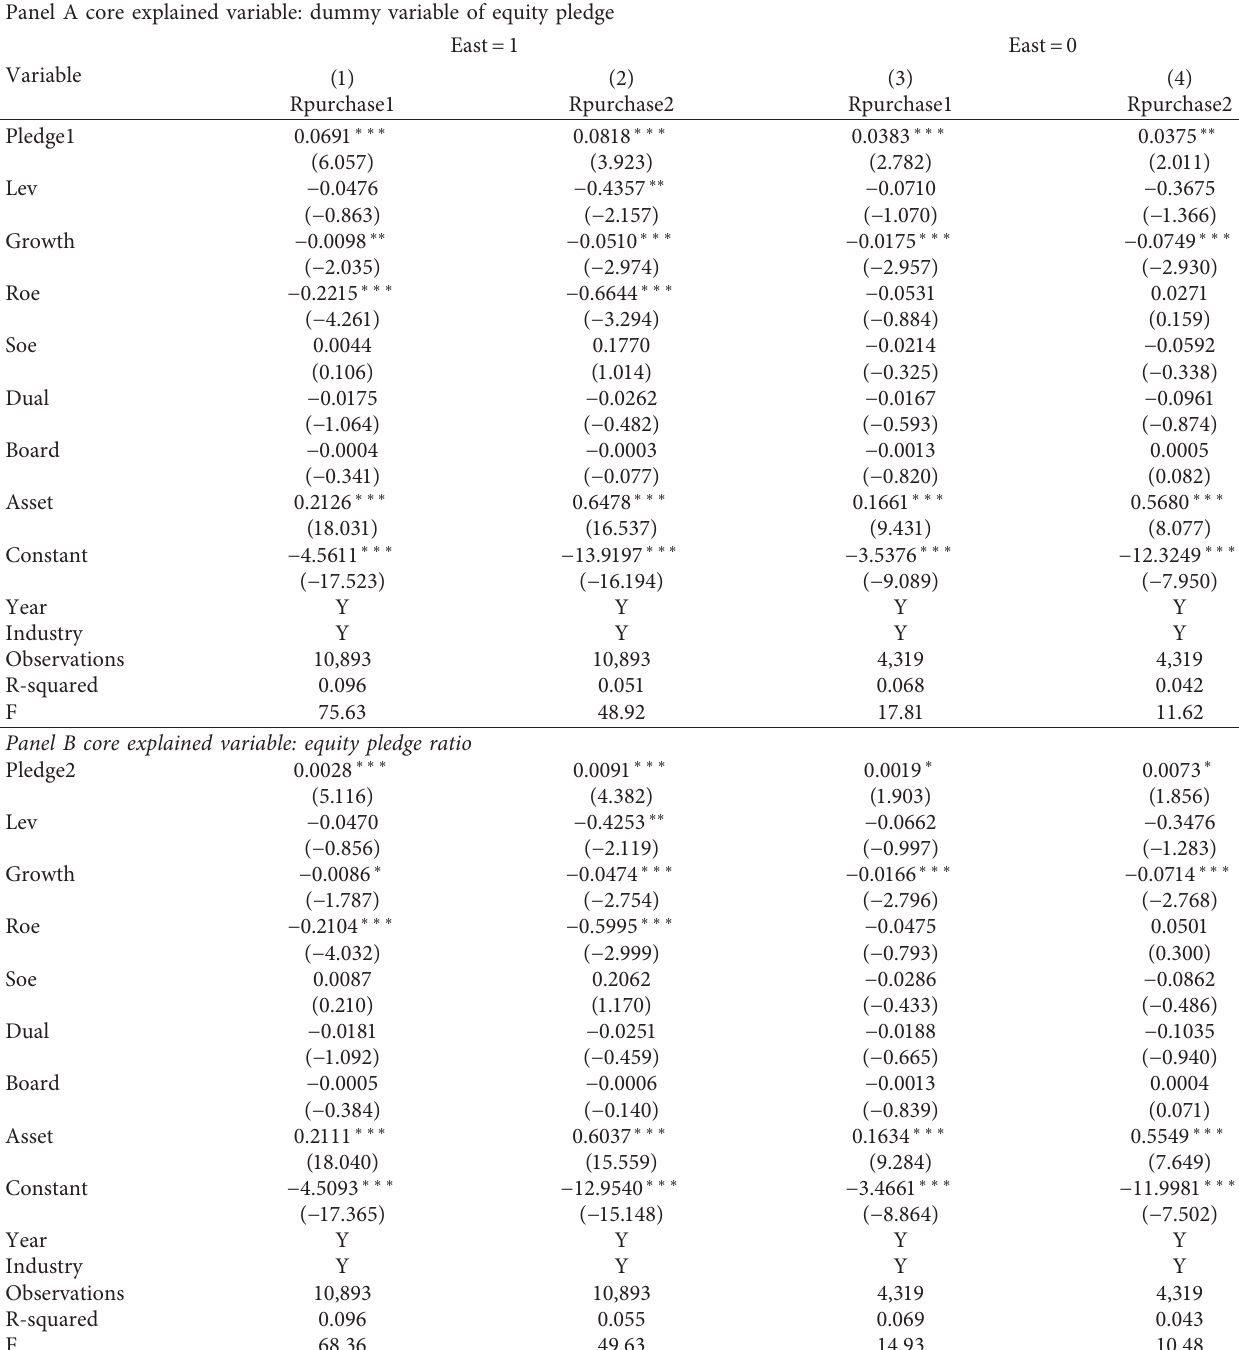
Table 8: Regression results of regional differences, controlling shareholders’ equity pledge, and listed companies’ stock repurchase. Panel A core explained variable: dummy variable of equity